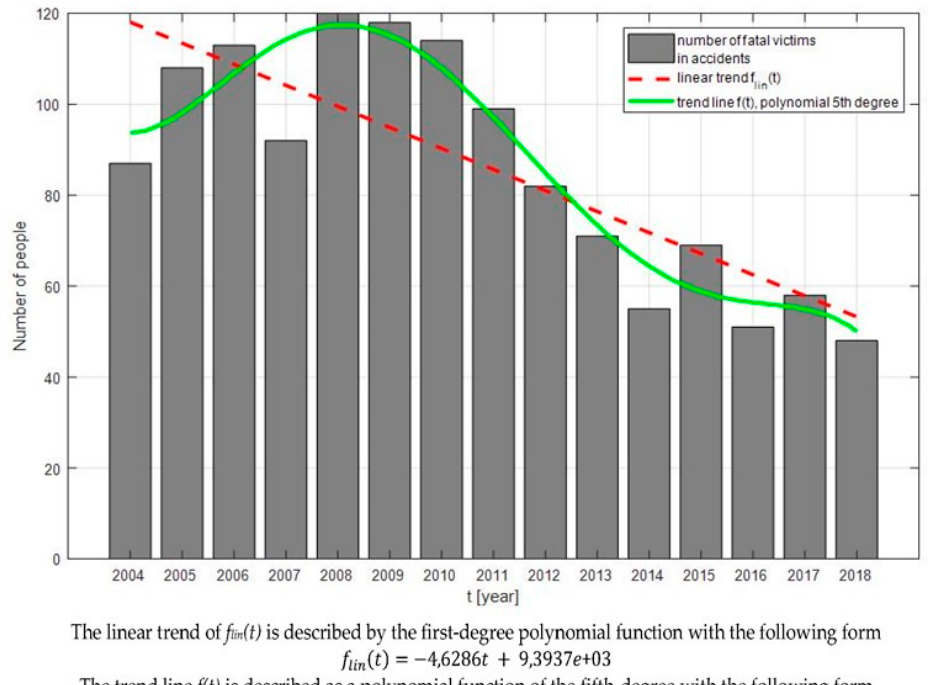
Figure 2. Trends of changes in the number of fatally injured civil engineering workers over time.